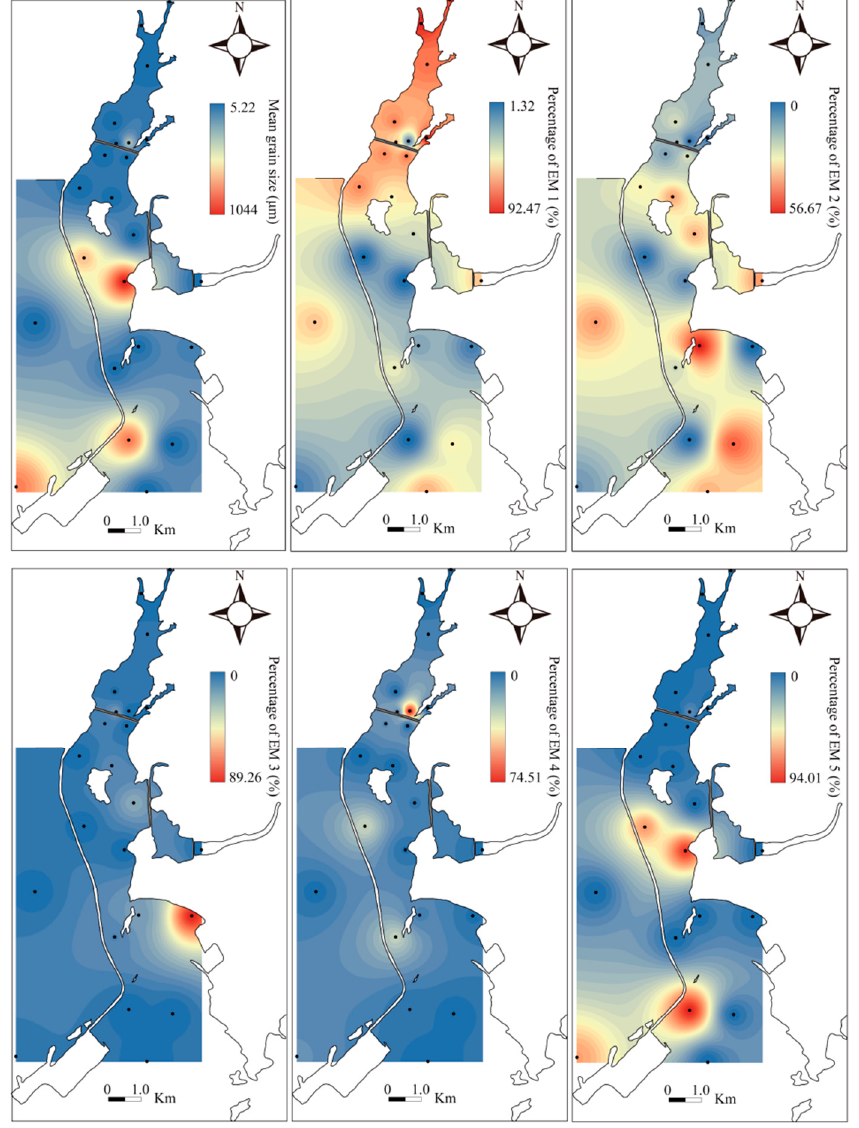
Figure 7. Distribution of average grain size and endmember components of 24 sediment samples in the Lu’erhuan River Sea area of Qinzhou Bay, Guangxi Province.